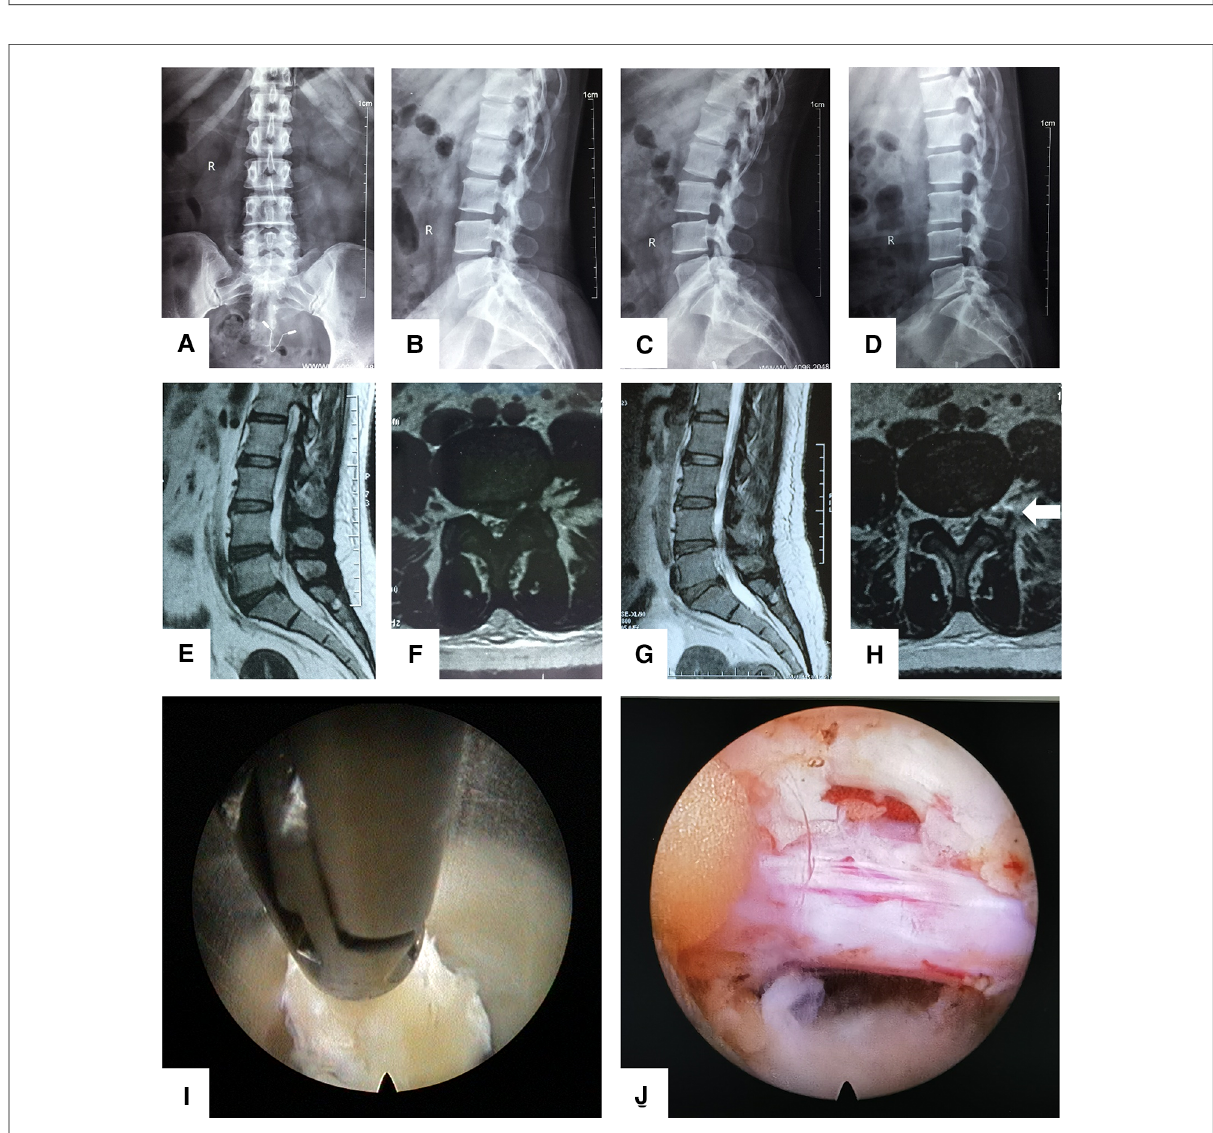
FIGURE 5 A 34-year-old female patient had radiating pain in the left lower extremity. (A-D ): She underwent lumbar anteroposterior and lateral x-ray radiographs and lumbar over fl exion-extension x-ray radiographs. The imaging data showed no lumbar instability. ( E-F ): Preoperative axial and sagittal MRI (T2WI) results showed L4/5 LDH with nerve root compression. ( G-H ): The postoperative MRI scans (1 day after surgery) of this patient show that the herniated intervertebral disc resection was satisfactory, and the structure of the lumbar facet joint was fully preserved (white arrow). ( I-J ): The herniated intervertebral disc was removed under